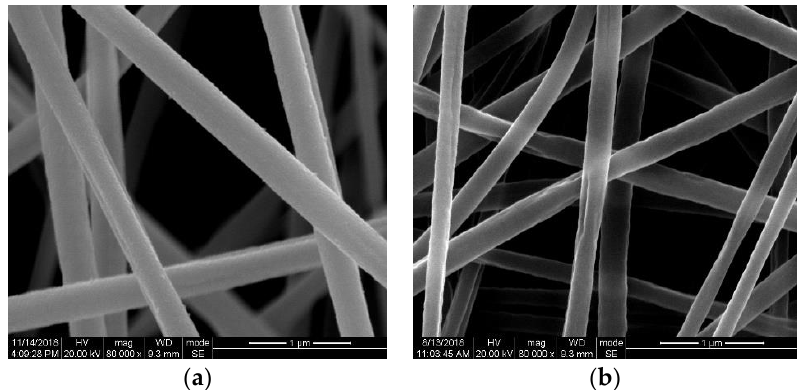
Figure 4. SEM image of the synthesized nanostructure ( a ) before and ( b ) after the H 2 test.